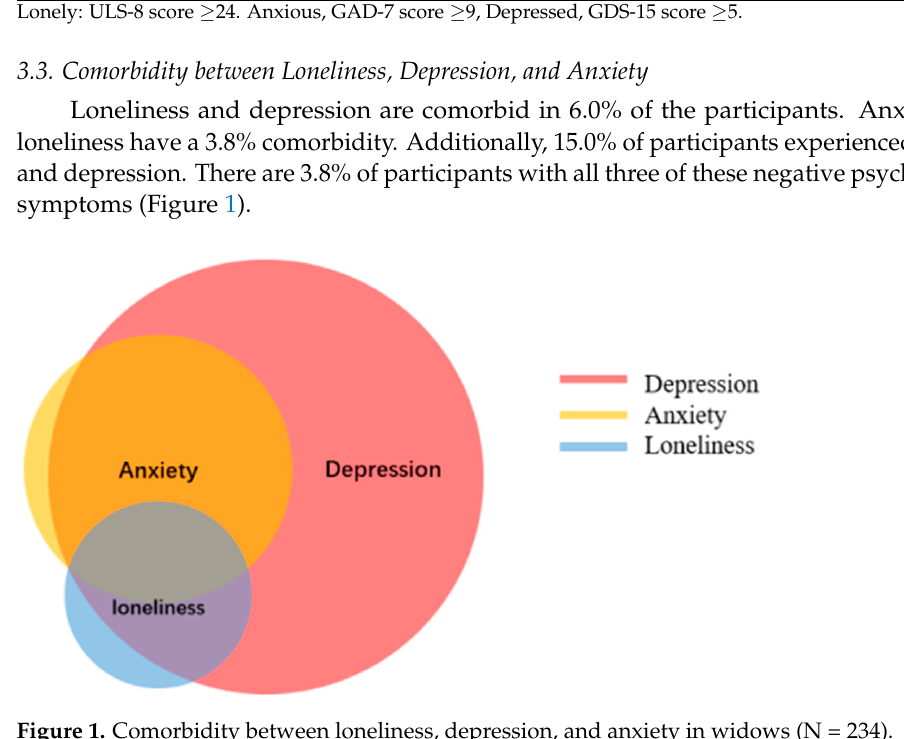
Figure 1. Comorbidity between loneliness, depression, and anxiety in widows (N = 234). Univariate analyses were conducted to test the differences in socio-demographic and widowhood-related factors in loneliness, depression, and anxiety symptoms. Acute or chronic medical conditions, marital happiness, being the primary caregiver before widow- hood and anticipating the death of the spouse were associated with negative psychological symptoms ( p < 0.05) (Table